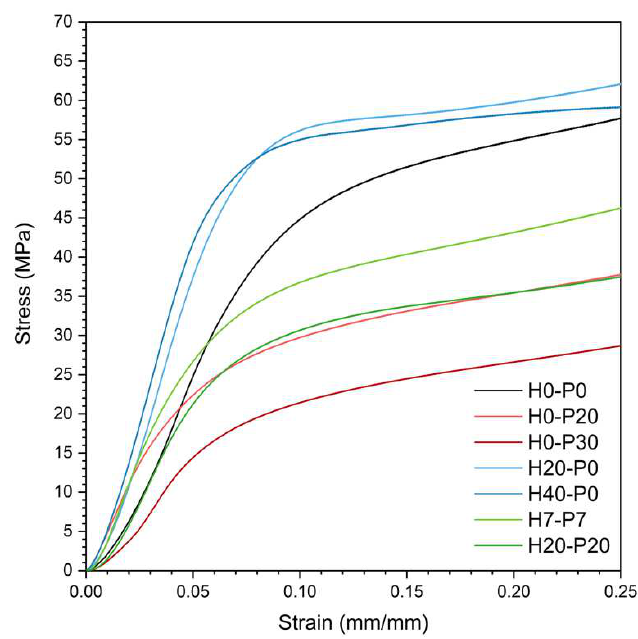
Figure 11. Compressive stress–strain curves for some selected representative compositions. Table 6. Compressive properties of the prepared foams.